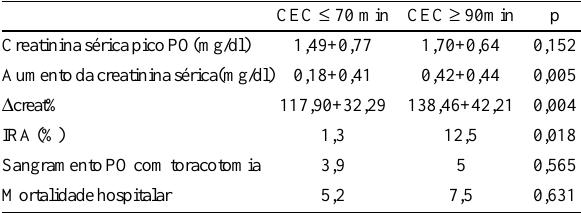
operatória sérica em porcentagem, IRA= insuficiência renal aguda.